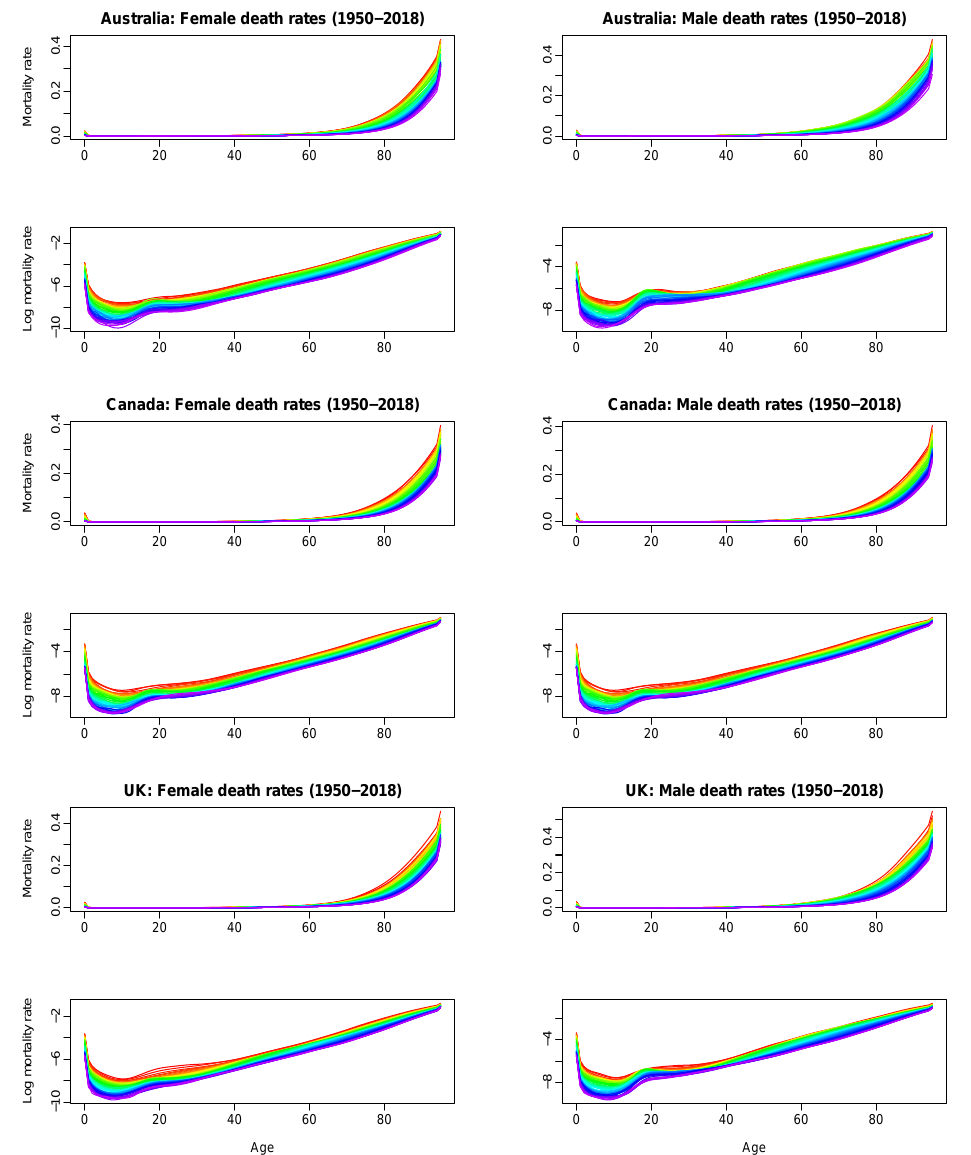
Figure 1. Functional time series plots of smoothed mortality and log mortality rates for Australia (rows 1–2), Canada (rows 3–4), and the UK (rows 5–6): female ( left panels ) and male ( right panels